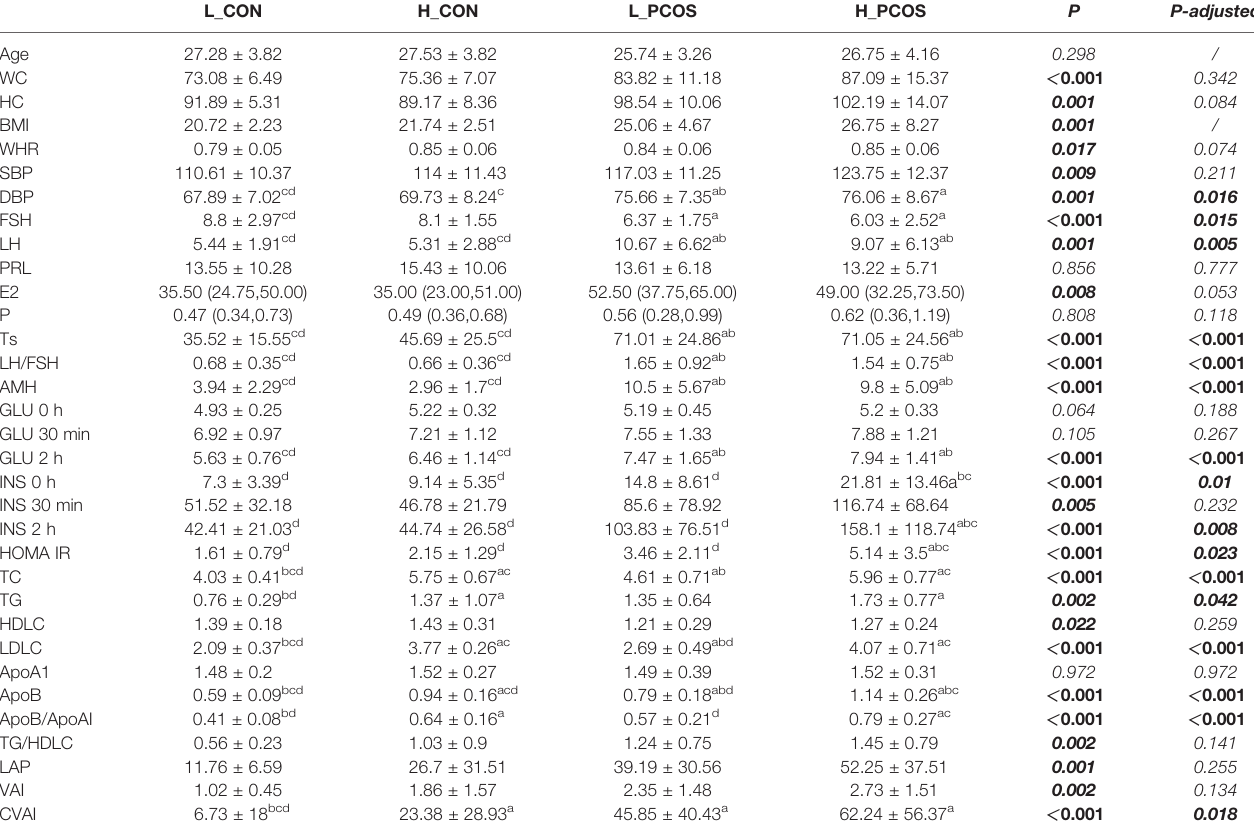
TABLE 2 | Anthropometric and metabolic parameters of all participants.